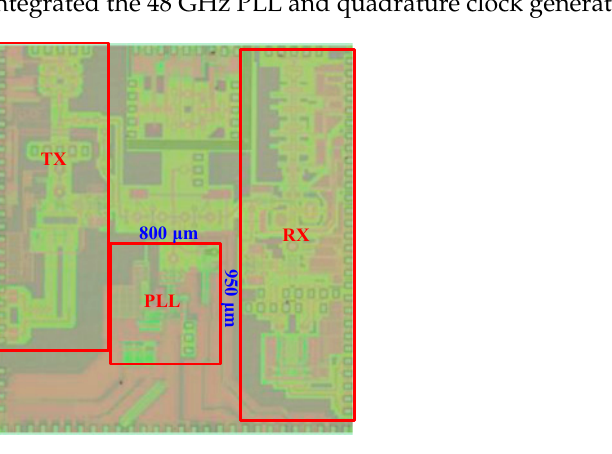
Figure 15. Phase delay with respect to the control bits.